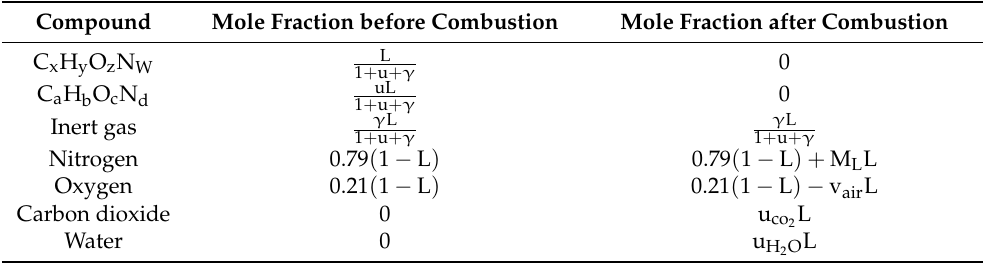
Table 1. Composition of mixtures before and after